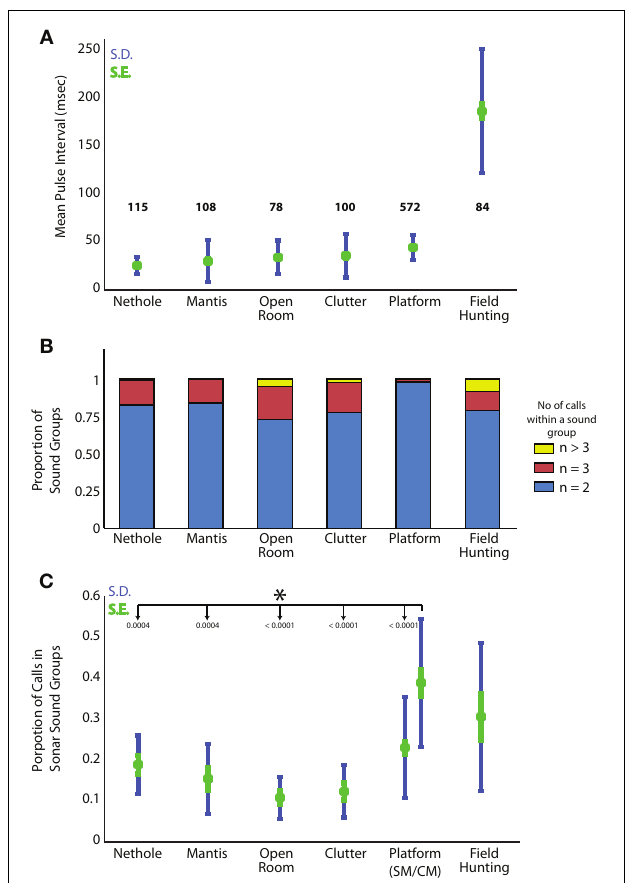
FIGURE 6 | Sound group parameters across conditions. (A) Mean pulse interval time for sound groups in each experimental condition. Standard error in green, standard deviation in blue. The mean P.I. for bats hunting in the field is significantly greater than all other experiments. Refer to Table 3 for a pairwise comparison of the mean sonar sound group PI between conditions. (B) Proportion of 2, 3, or ≥ 3 call sound groups produced in each experimental condition. (C) Proportion of sounds produced by the bats in sonar sound groups as compared to the total number of sounds produced under different behavioral conditions. Standard error in green, standard deviation in